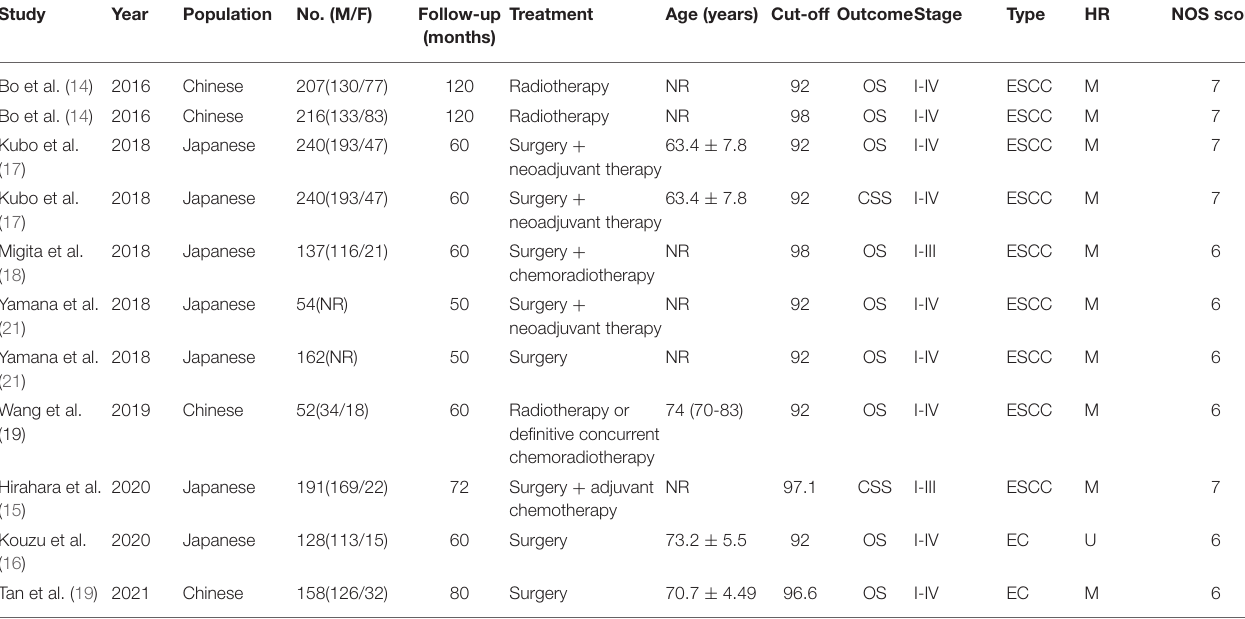
TABLE 1 | Main characteristics of all the studies included in the meta-analysis.